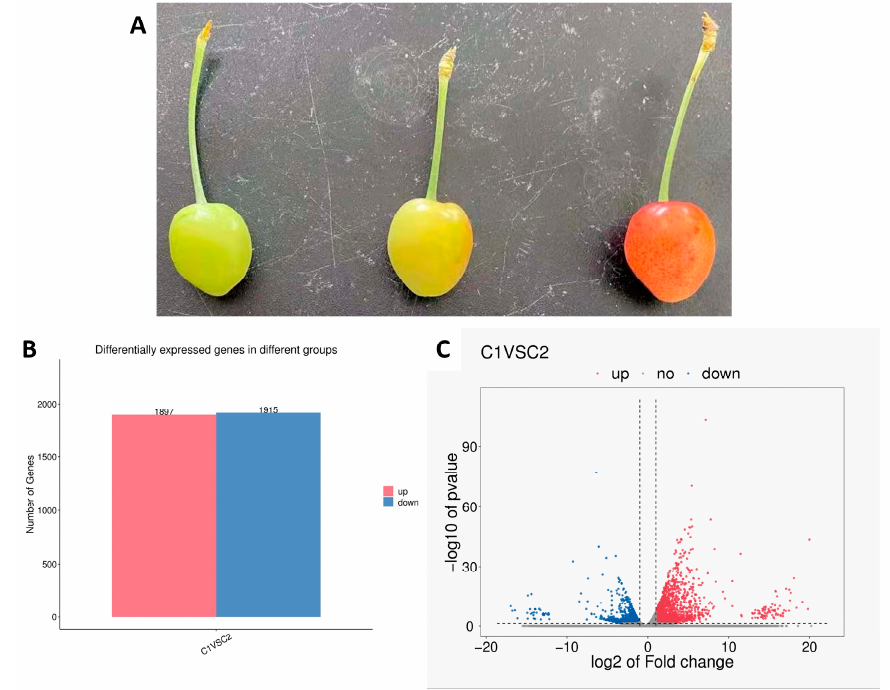
Figure 1. DEGs between young “Green Peel” and mature “Red Peel” sweet cherries. ( A ) Photograph of red peel, yellow peel and red peel sweet cherries; ( B ) Bar plot of DEGs; ( C ) As illustrated in the volcano plot, the difference in the expression level of genes displays statistical significance between the two groups of samples.